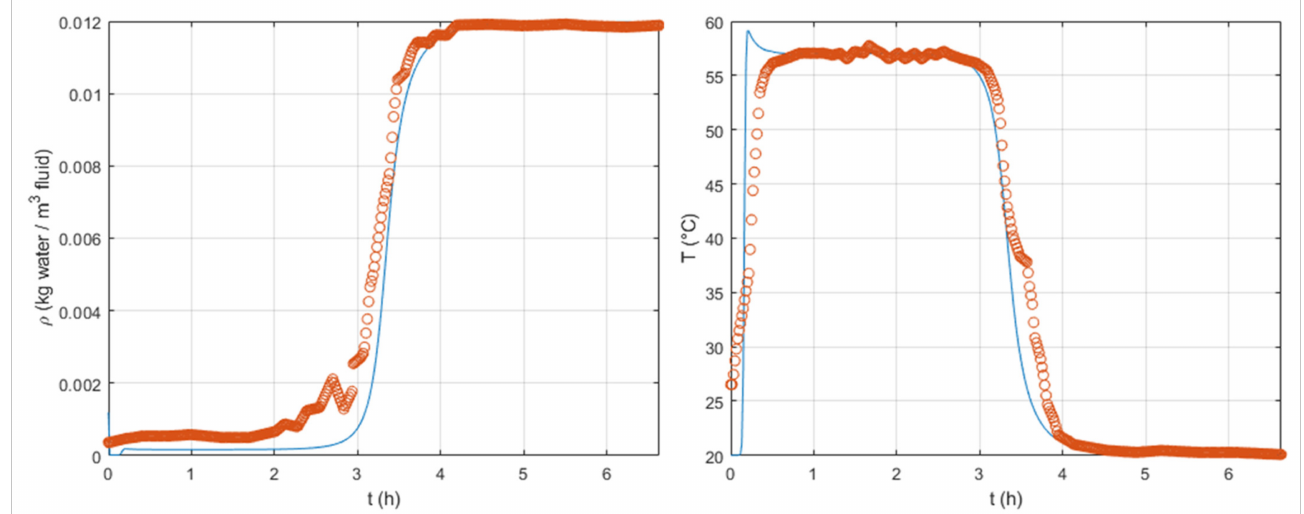
Figure 6. Simulated and experimental breakthrough curves with operating conditions at the column inlet of 0.12 m/s, 20 ◦ C, and 12 g/m 3 . Validation of the model.